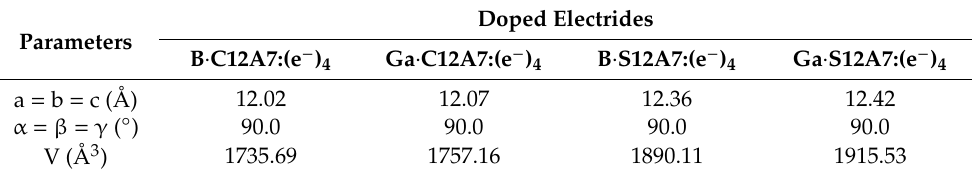
Figure 5. Relaxed cage structures of ( a , b ) B-doped and ( c , d ) Ga-doped electrides. Table 4. Calculated lattice parameters and volumes of doped electrides.